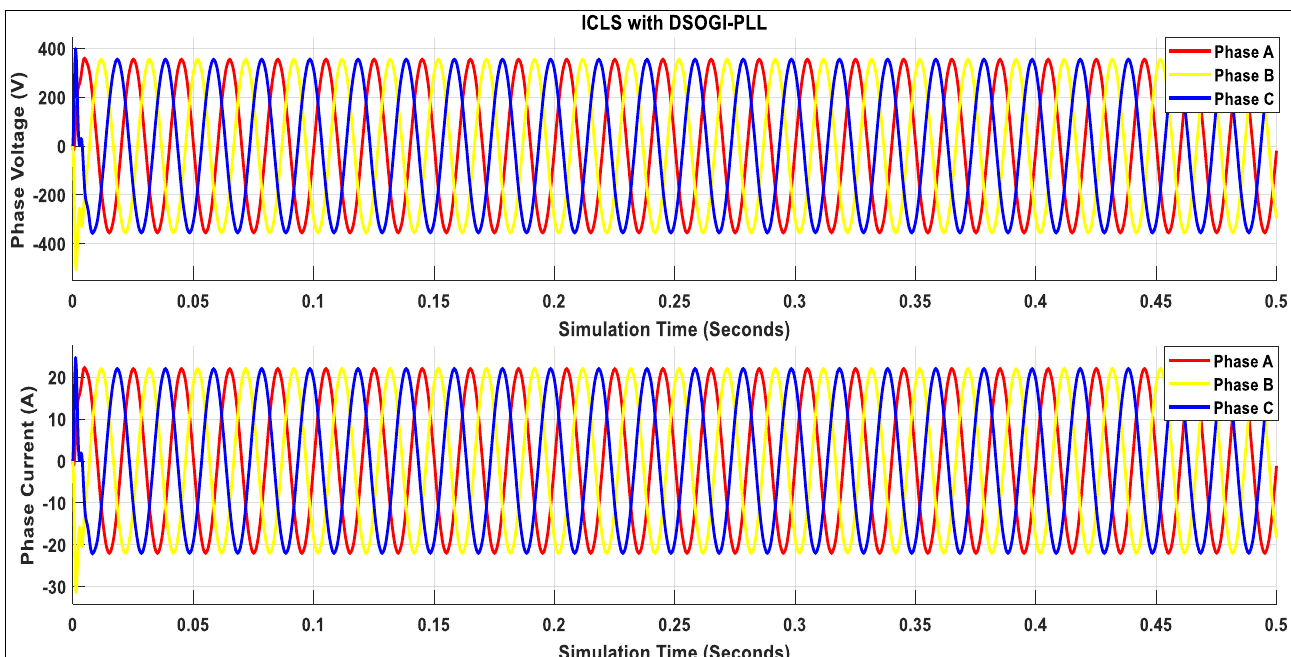
Figure 15. PSC pattern 2 FRMO-DSP MPPT results (case study 2).